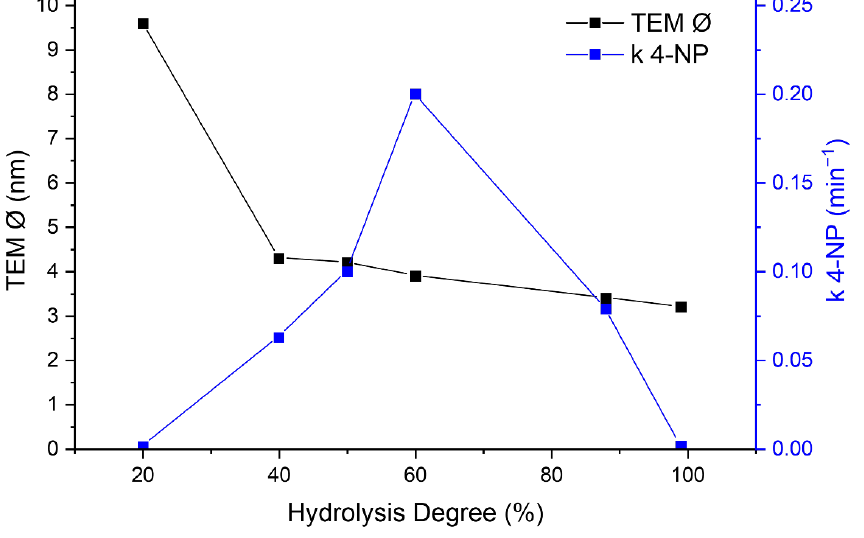
Figure 4. Effect of the PVA hydrolysis degree on the mean particle diameter (TEM Ø, in black) and the 4-NP reduction pseudo-first-order kinetic constant (k 4-NP, in blue).